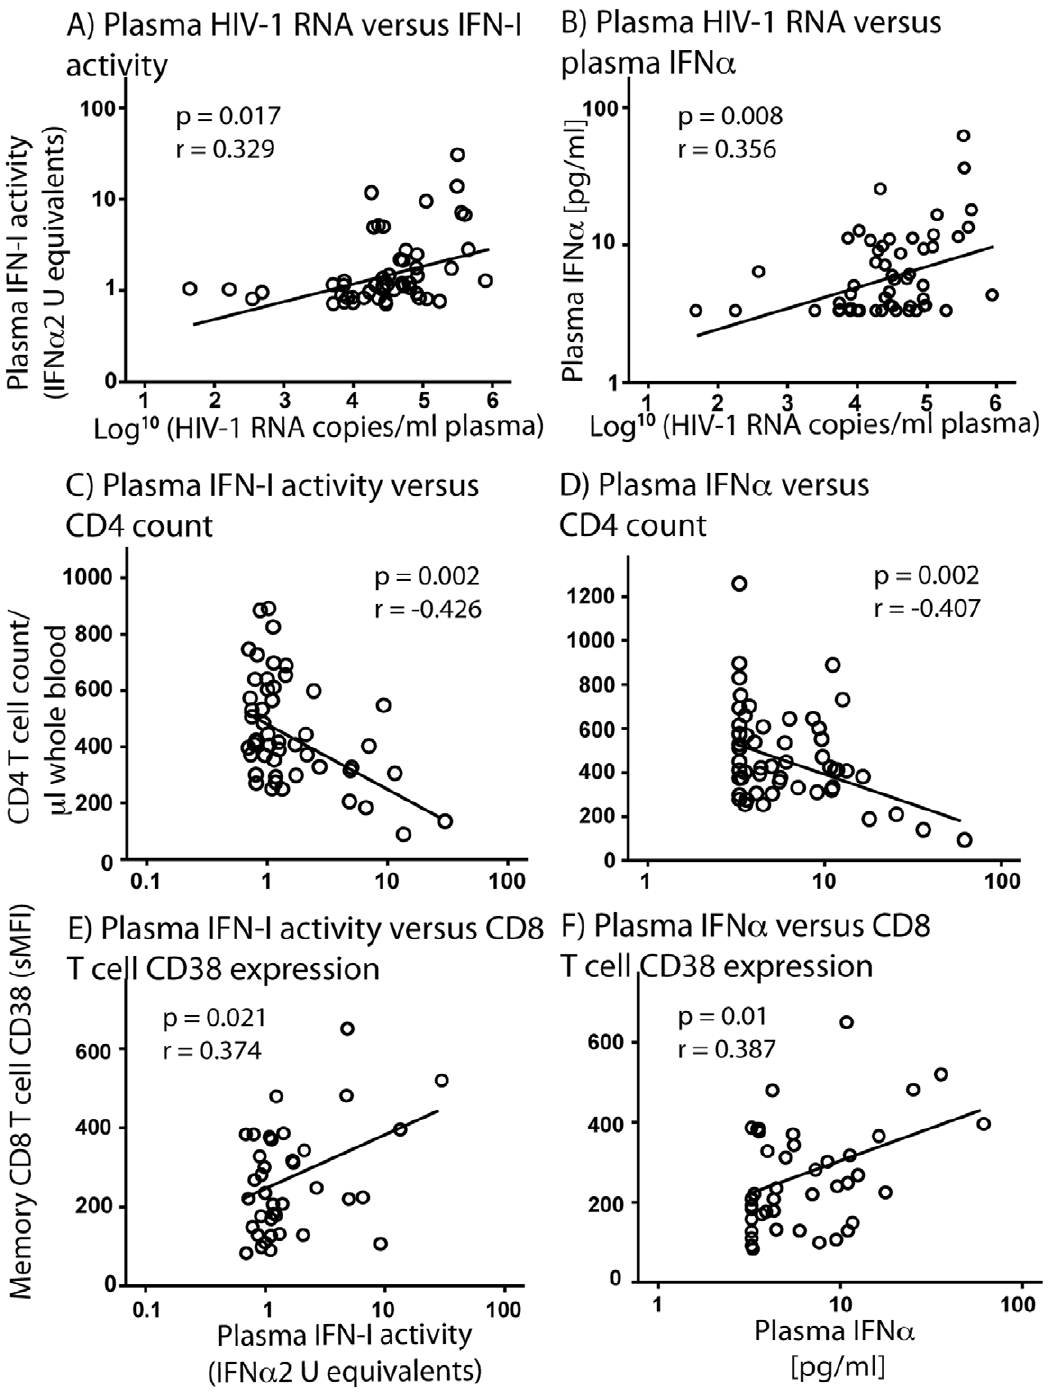
Figure 4. Plasma IFN a and IFN-I bioactivity are associated with plasma HIV-1 RNA levels, CD4 T cell count and immune activation in untreated subjects with chronic HIV-1-infection. Plasma HIV-1 RNA levels in HIV-1-infected subjects without ART correlated positively with plasma IFN-I bioactivity (r=0.329, p=0.017) (A), as well as with plasma IFN a (r=0.356, p=0.008) (B). Absolute CD4 T cell count in these subjects correlated inversely with plasma IFN-I bioactivity (r=-0.426, p=0.002) (C) and plasma IFN a (r=-0.407, p=0.002) (D). Expression of CD38 by memory (CD45RO + ) CD8 T cells in these subjects correlated positively with plasma IFN-I bioactivity (r=0.374, p=0.021) (E) and with plasma IFN a (r=0.387, p=0.01) (F). doi:10.1371/journal.pone.0056527.g004 who had undetectable HIV-1 RNA for greater than 2 years, in uninfected subjects. These data suggest that expression of IFN a plasma IFN a and IP-10 levels were comparable to those observed may be driven directly by HIV-1 viremia, or correlates thereof